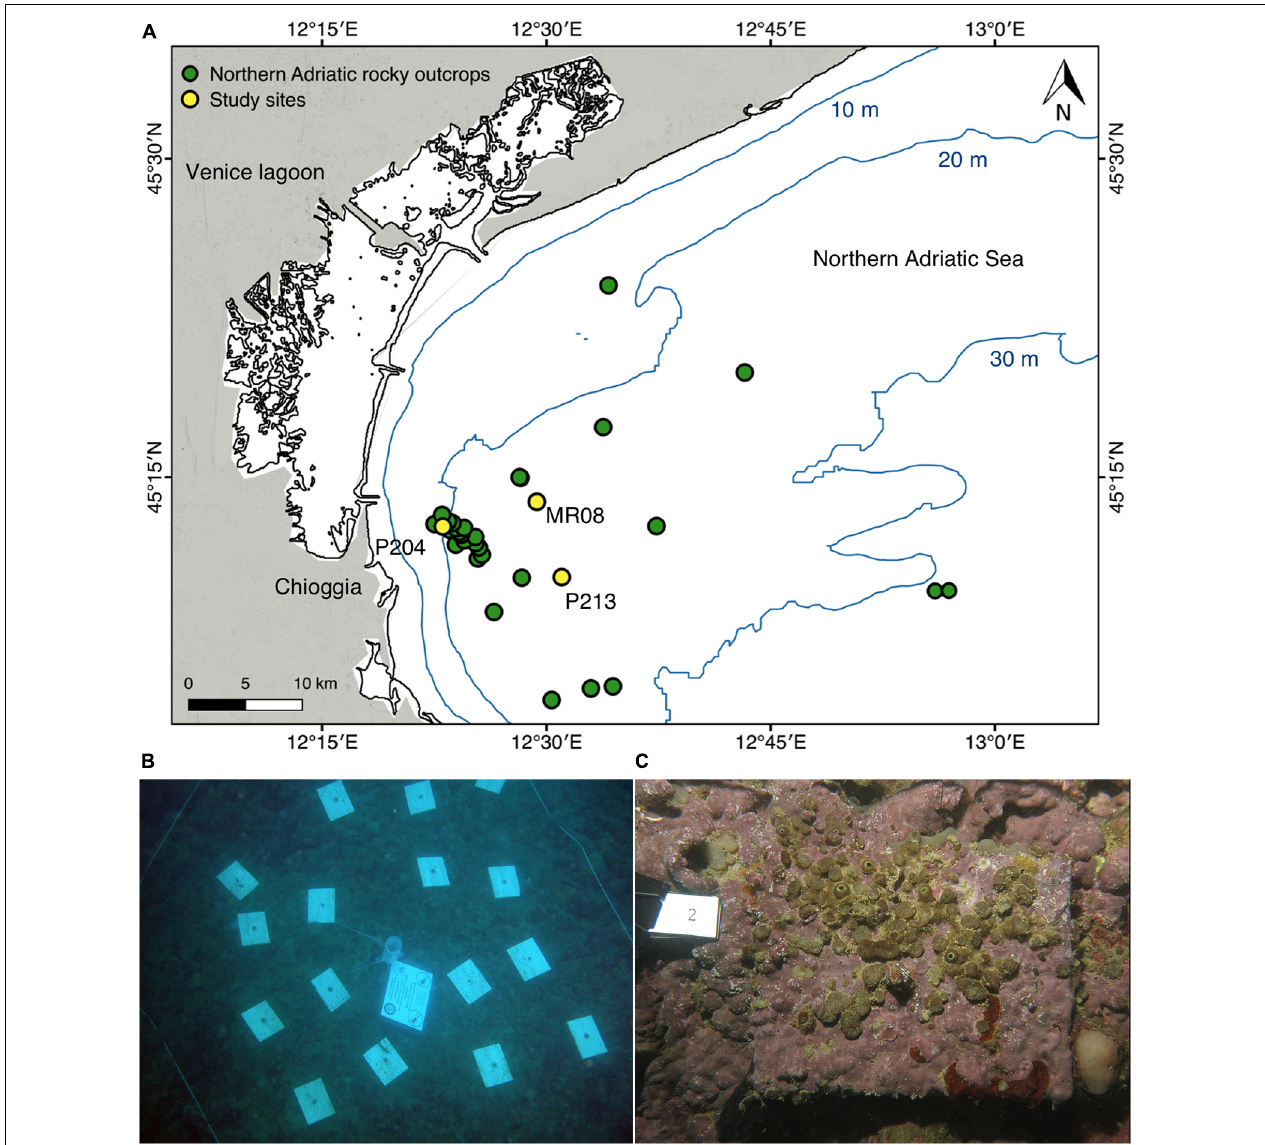
FIGURE 1 | Sites’ location and experimental setup. (A) Map of the study area showing the three experimental sites (P204, P213, MR08), yellow dots, and the main northern Adriatic Sea coralligenous reefs off Chioggia and Venice, green dots (Mercator Projection, Datum WGS84). (B) Example of travertine tiles arrangement at P204 study site. (C) Example of travertine tile exposed for 12 years at MR08